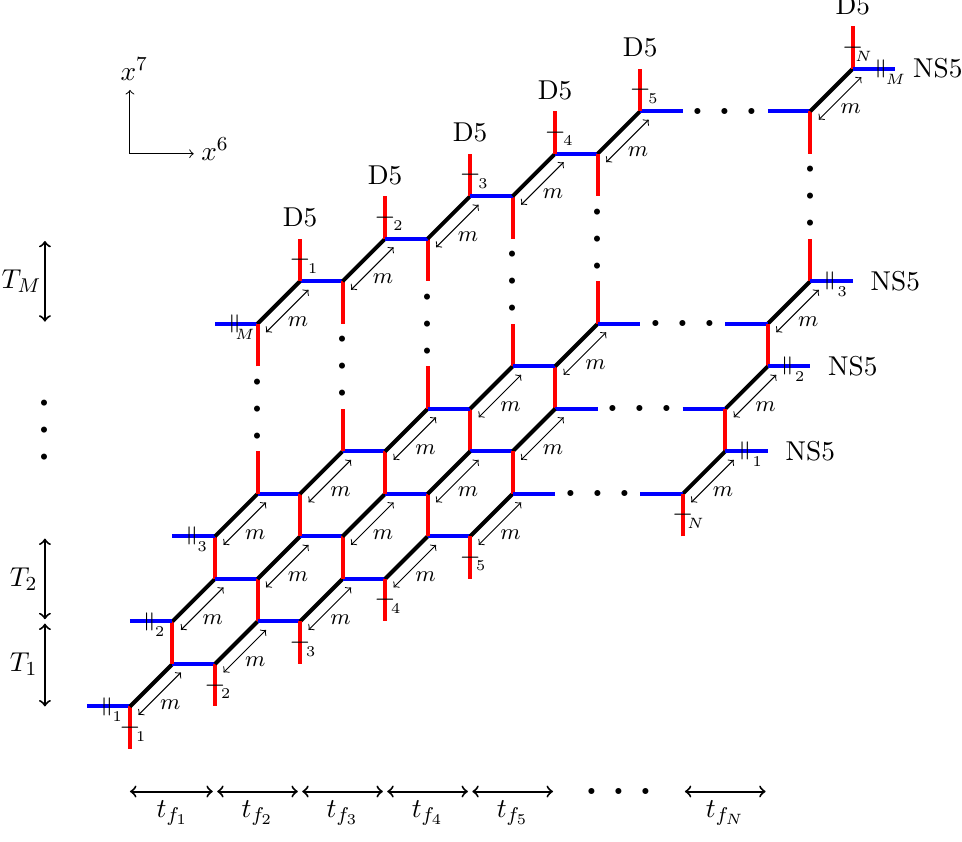
Figure 1 . Con(cid:12)guration of intersecting D5-branes (red) and NS5-branes (blue). The deformation parameter m introduced by the (1 ; 1)-branes (black) is chosen to be the same throughout the diagram. For j t f j < 1 , the D5-branes are arranged on a circle (compact case), while the non- N compact case corresponds to the limit t f ! 1 N